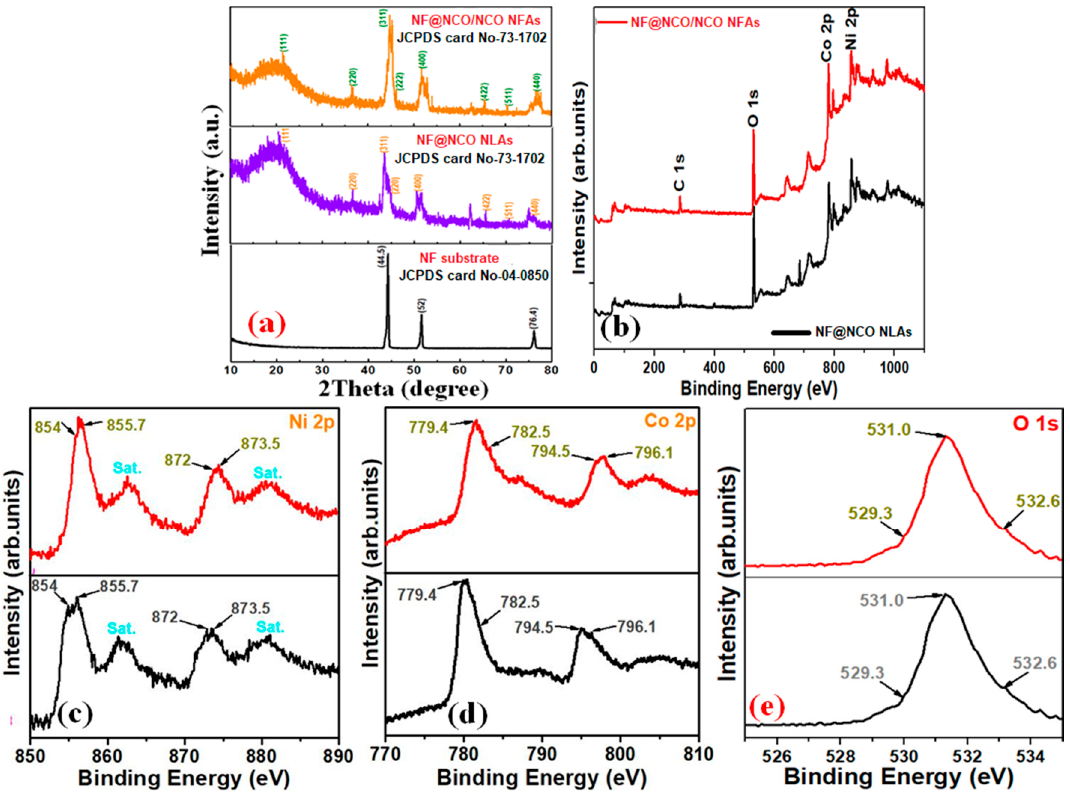
Figure 3. ( a ) XRD pattern of the as-synthesized NF@NCO/NCO NFAs, NF@NCO NLAs, and Nickel foam material, ( b ) XPS survey spectrum of NF@NCO NLAs and NF@NCO/NCO NFAs, and ( c – e ) high-resolution XPS spectrum of Ni 2p ( c ), Co 2p, and O1s ( e ) for NF@NCO/NCO NFAs and